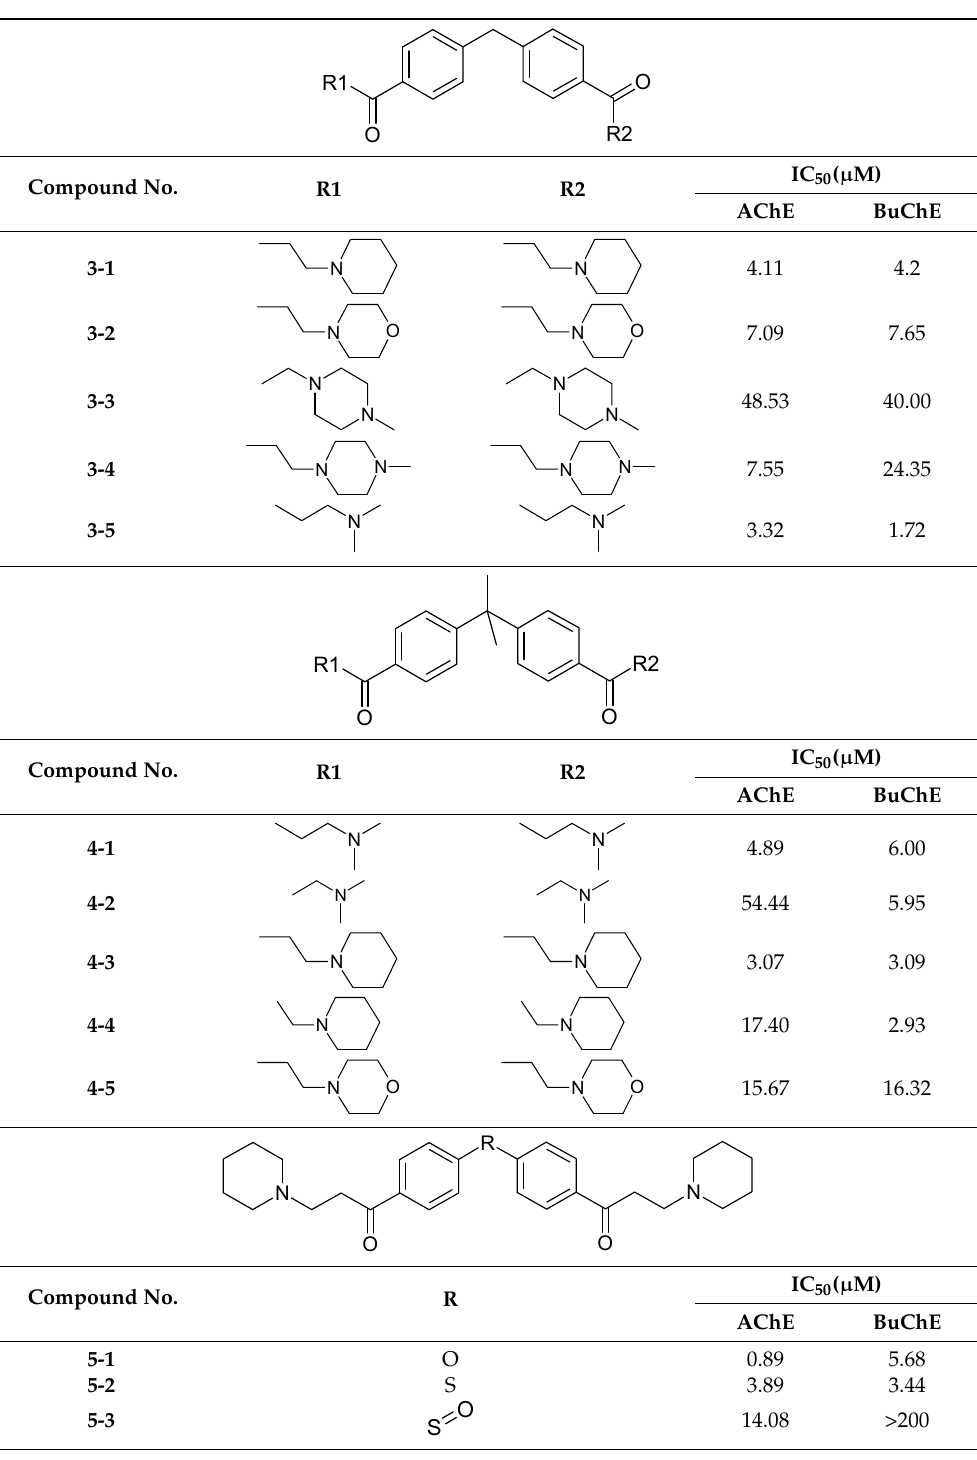
Table 1. The chemical structures and biological activities of DL0410 and its 50 derivatives as AChE and BuChE inhibitors.